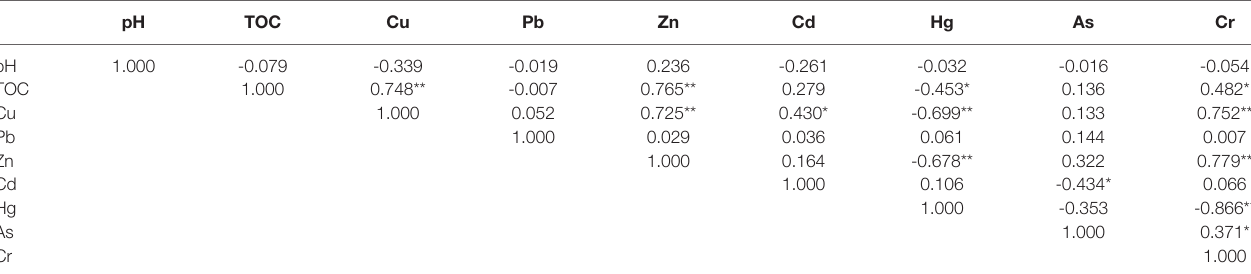
TABLE 6 | Correlation analysis between heavy metal concentrations and the environmental parameters in